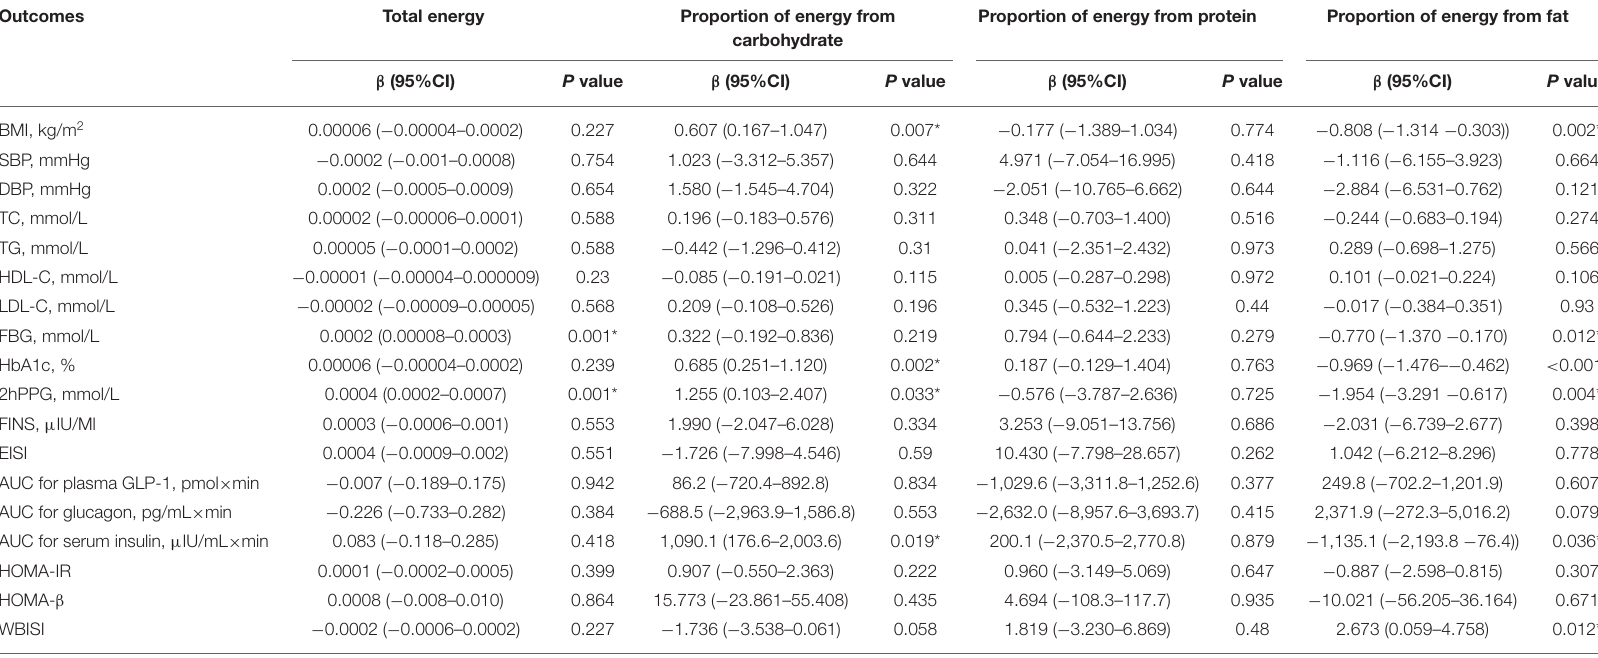
TABLE 3 | Independent effects of dietary intakes on clinical outcomes in linear mixed-effect